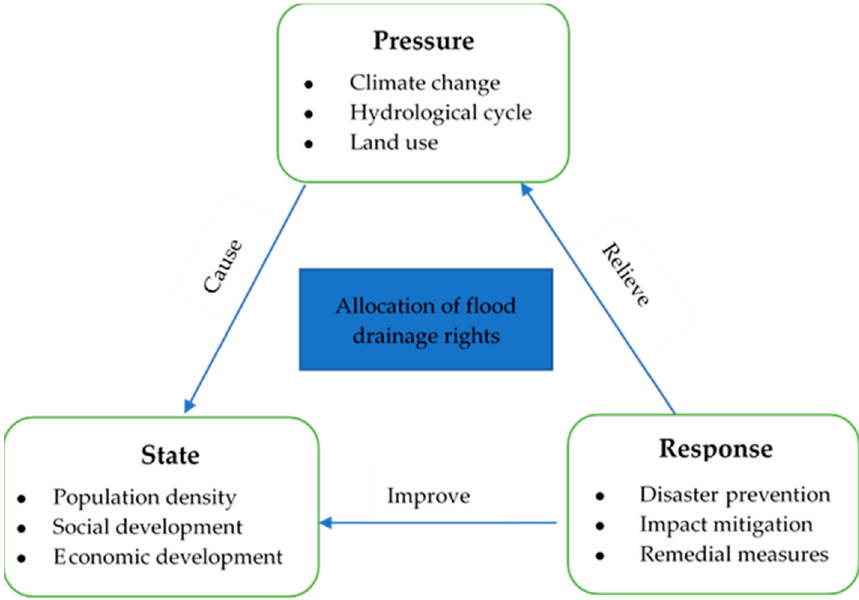
Figure 2. Pressure–state–response framework.